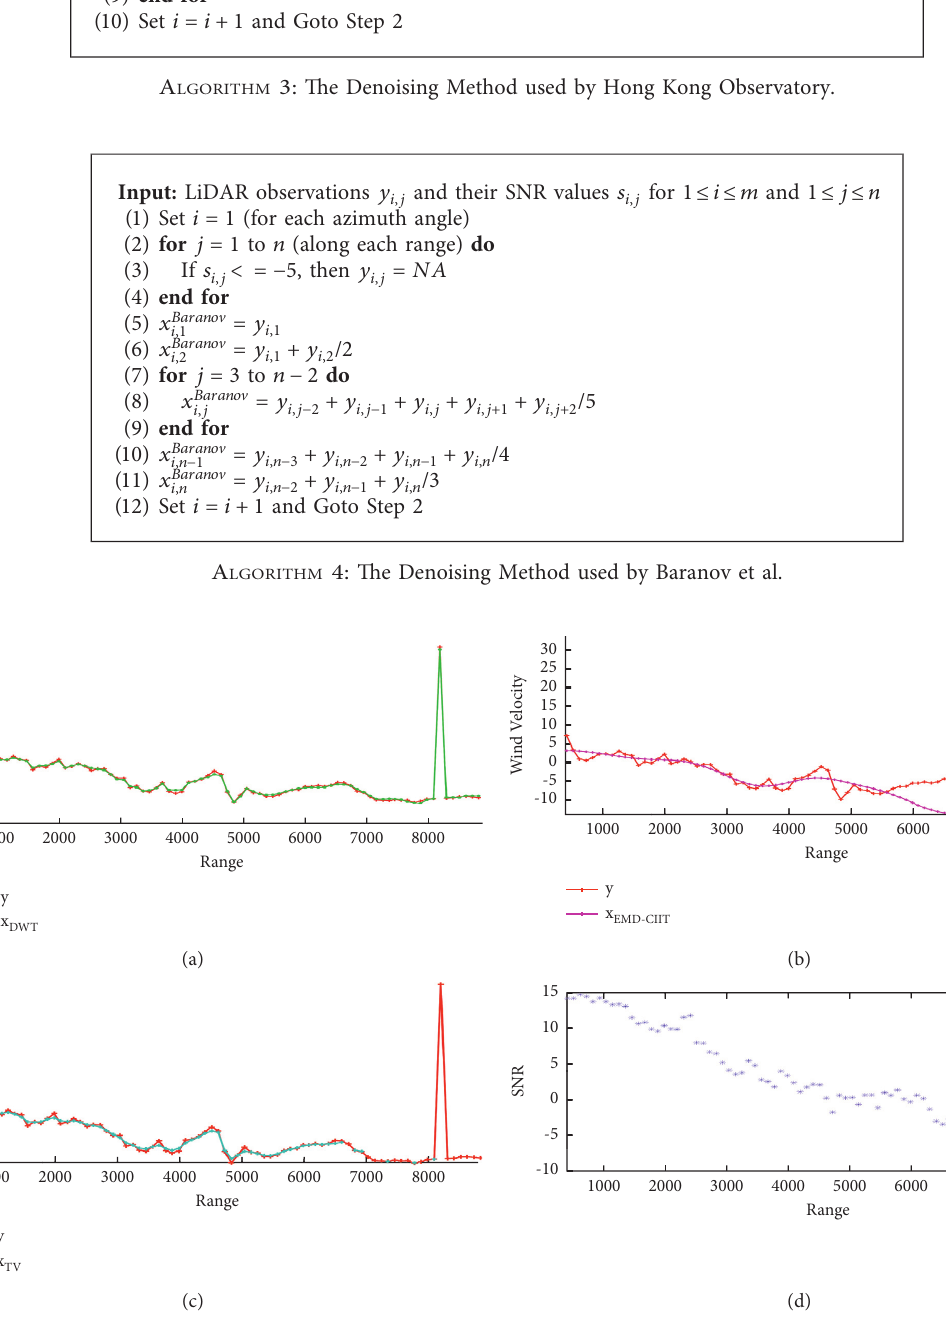
Figure 3: The denoising results by the “DWT” (a), “EMD-CIIT” (b), and our proposed scheme (c) for the LiDAR data collected on 5 March 2015 from 04:16: 02 to 04 :16:25 with a fixed azimuth angle (224 . 0 ° ). The SNR values of the corresponding observed LiDAR data are shown in